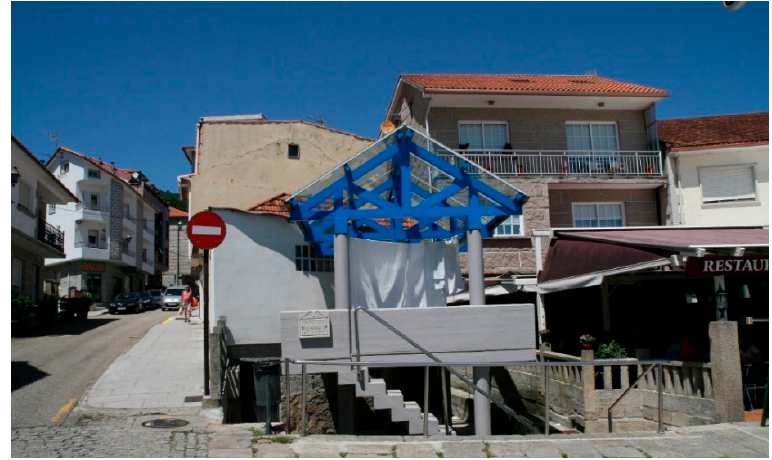
Figure 5. Plastic roof on the s econd level of the community laundry, Combarro, designed by Pascuala Campos de Michelena (Authorship: AFC).